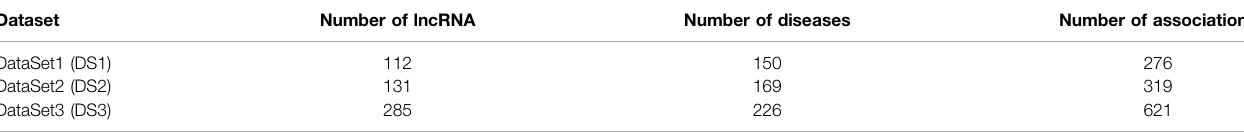
TABLE 1 | LncRNA – disease association relationship